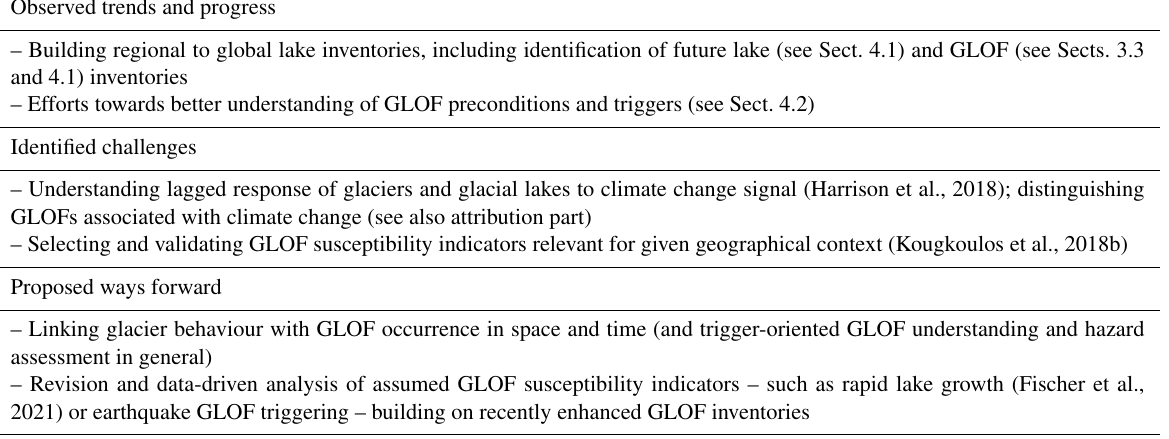
Table 2. Summary of the key topics, observed trends, identified challenges and proposed ways forward in the thematic area understanding GLOFs – timing and